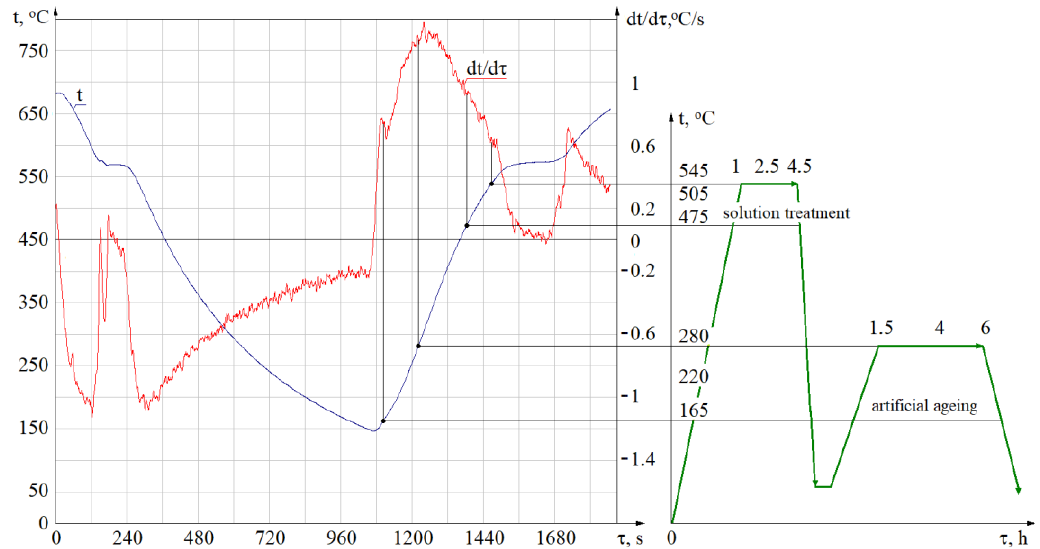
Figure 1. Solution treatment and artificial ageing temperature ranges selected by means of the TDA method.